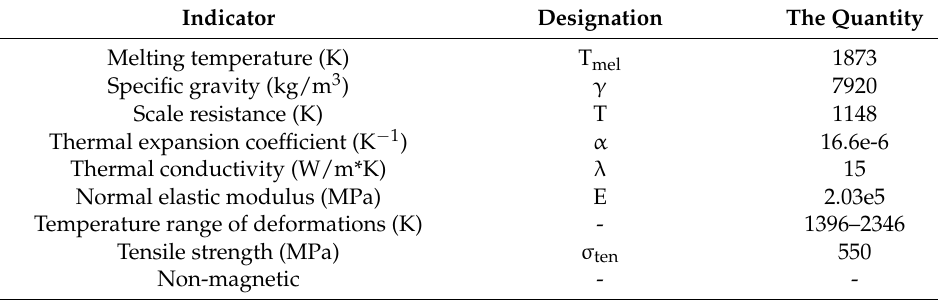
Table 6. Physical and mechanical properties of 12KH18N10T steel.